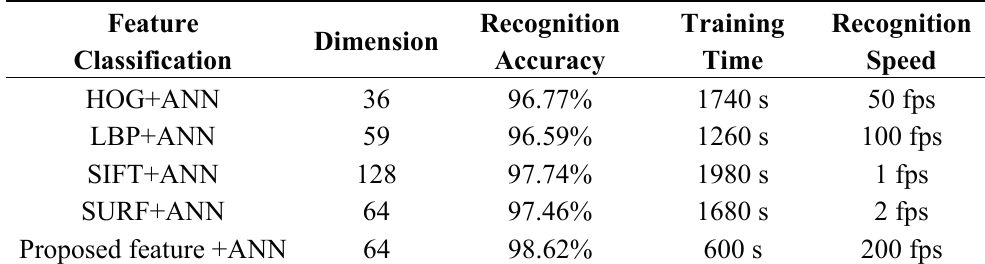
Table 6. Comparison with other works for the GTSRB data set.